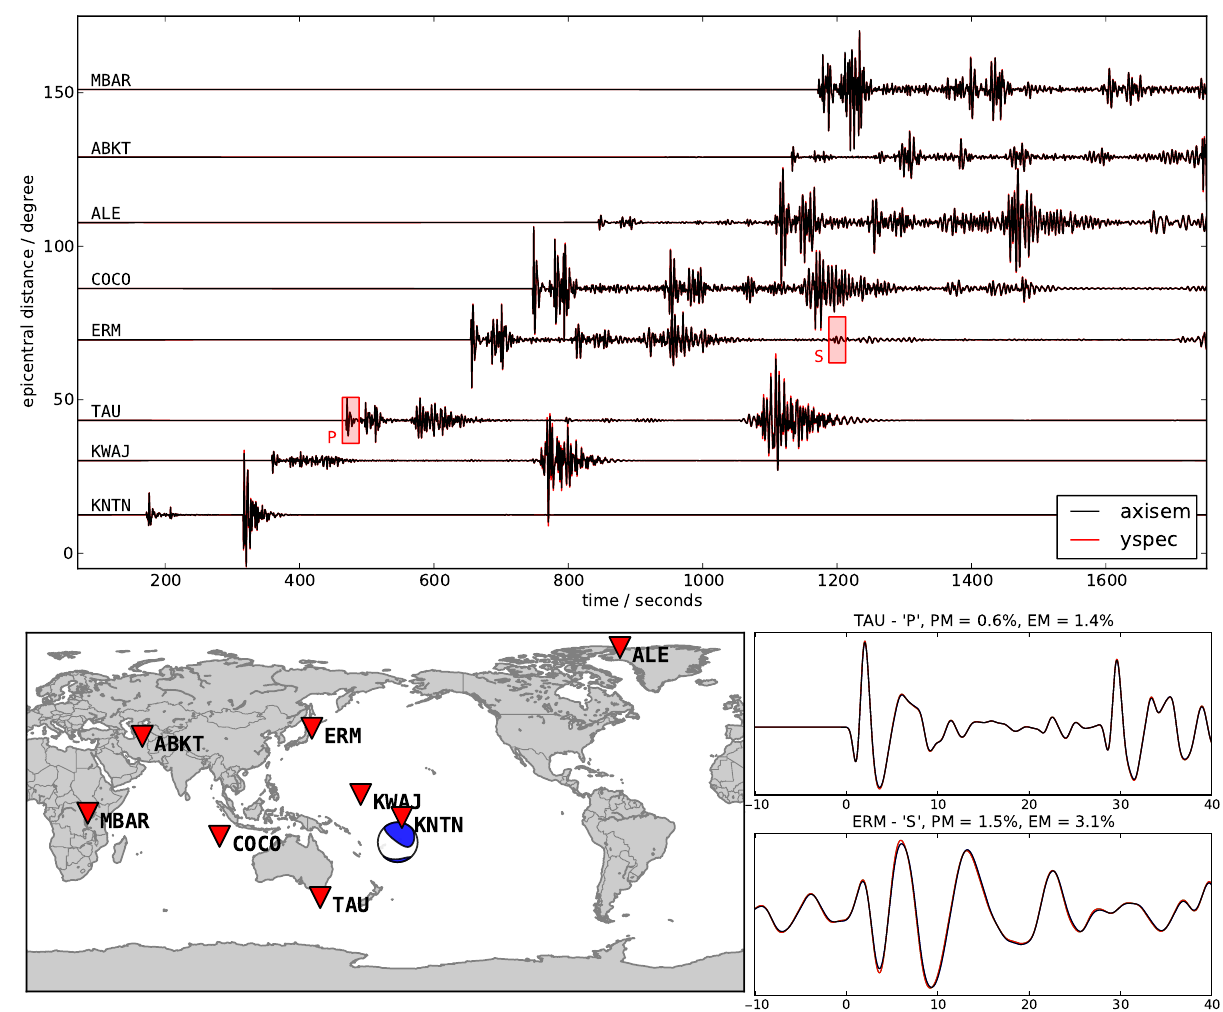
Figure 11. High-frequency validation (1Hz dominant frequency) between AxiSEM and YSpec. Top: Record section for vertical displacements of an M4.1 event in Tonga (depth: 126km), recorded at the stations shown on the map (bottom left) as red triangles. The background model is PREM, including anisotropy and attenuation, and the traces are filtered between seismic frequencies of 0.1–1Hz, i.e., at the limit of recordable signals in global seismology. The traces from AxiSEM and Yspec are virtually indistinguishable. The zoom sections for individual seismograms (bottom right) in P and S waves (red boxes) represent phases that traveled 500 and 1200 wavelengths, respectively. Time in these panels is normalized to the ray-theoretical phase arrivals ( Crotwell et al., 1999), and includes phase (PM) and envelope misfits (EM) measured following Kristekov´a et al. (2009).